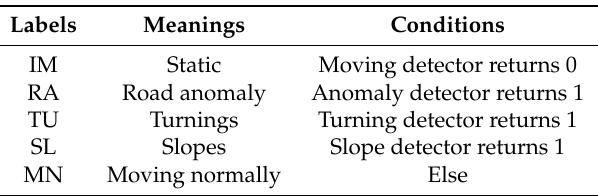
Table 1. Meanings and conditions of